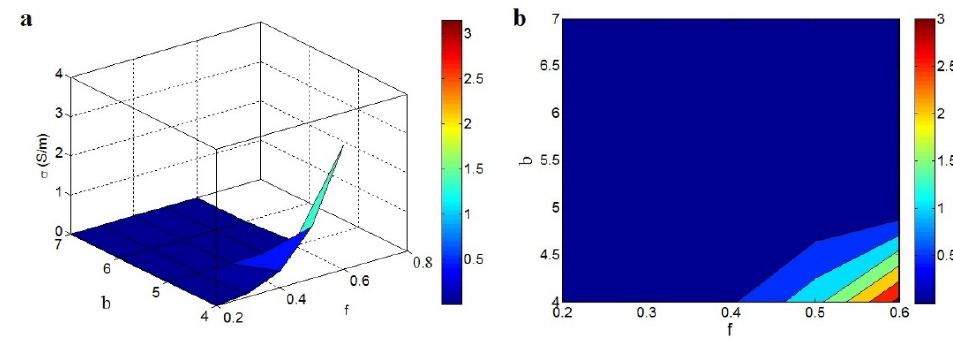
Figure 7. Correspondences of conductivity to f and b : ( a ) 3D and ( b ) 2D designs.